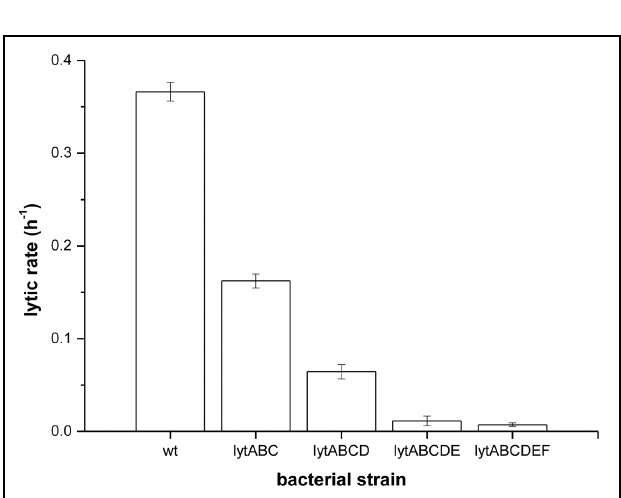
FIGURE 4 | Lytic rates of different lyt mutants measured as a rate of OD 650 decrease after treatment with prodigiosin (5.9 mg L − 1 ) in LB medium at 37 ◦ C and 200 rpm. Data are presented as averages and standard deviations ( n =